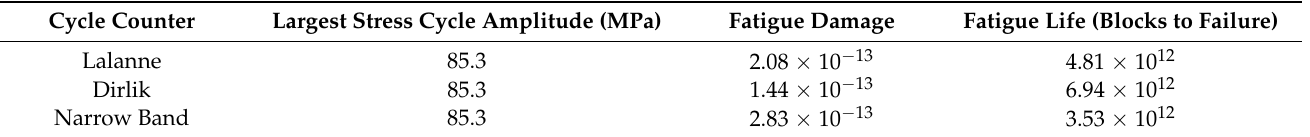
Table 10. Fatigue life results for the 0.25 mm lattice